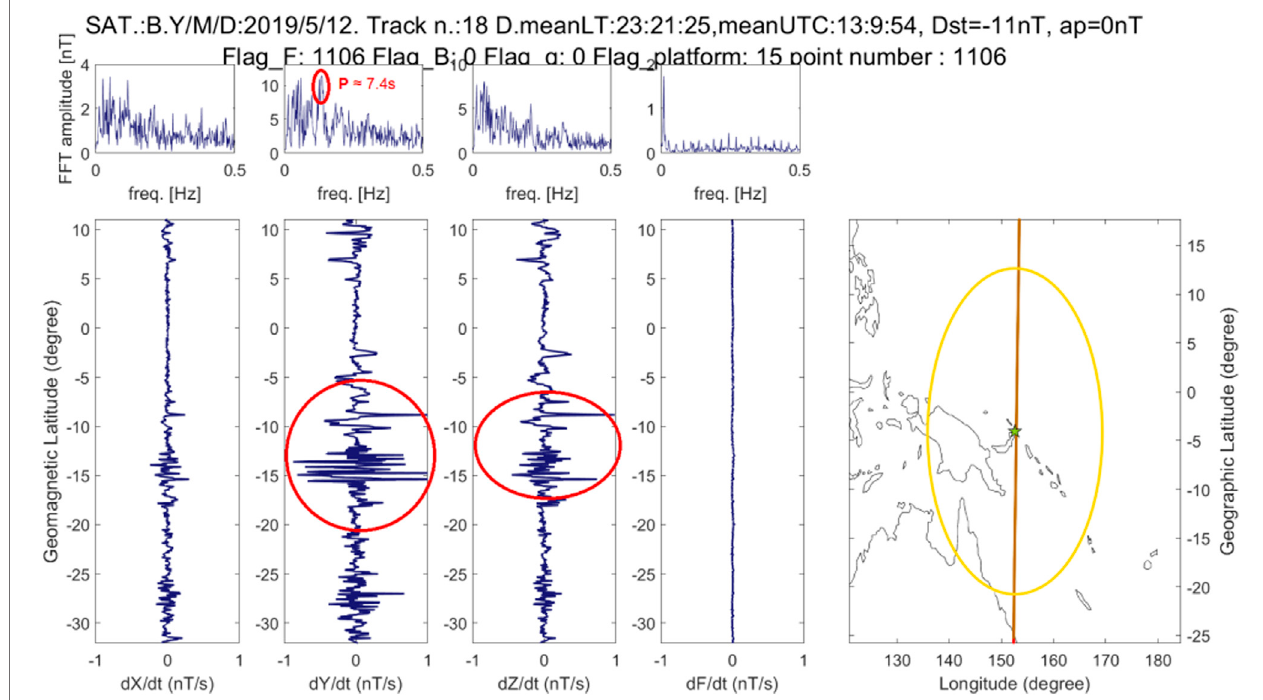
FIGURE7| SwarmBnight-timedataanalysisofthetrackthatpreceded theearthquakebyabout2 days( − 1.99 days).Thesameelementsof Figure8 areshown, and, in addition, the FFTofthe signal inside the Dobrovolsky area isreported for each magnetic fi eldcomponent and total intensity. ForY magnetic fi eldcomponent, the FFT evidences a peak at 7.4 s.